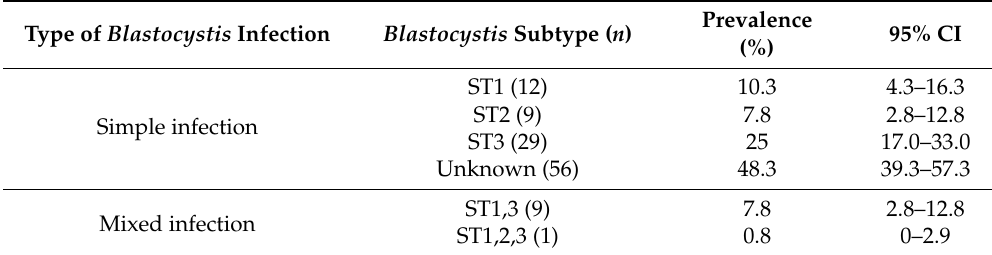
Table 1. Frequency and prevalence of Blastocystis subtypes 1, 2, and 3 (ST1, ST2, and ST3) and the type of infection identified in the tested